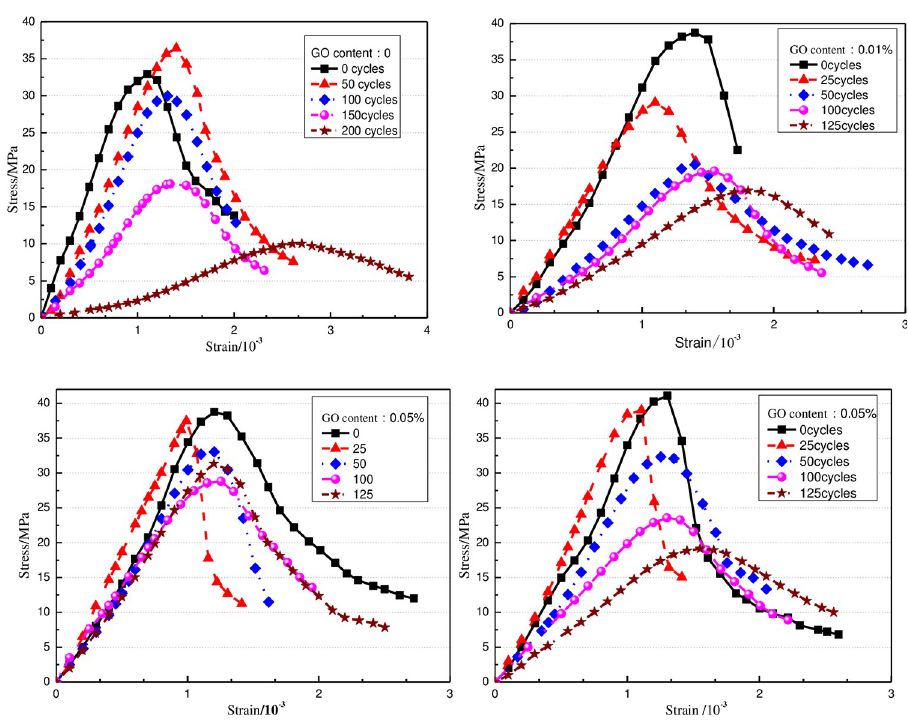
Fig 12. Stress-strain relationship of concrete under freeze-thaw